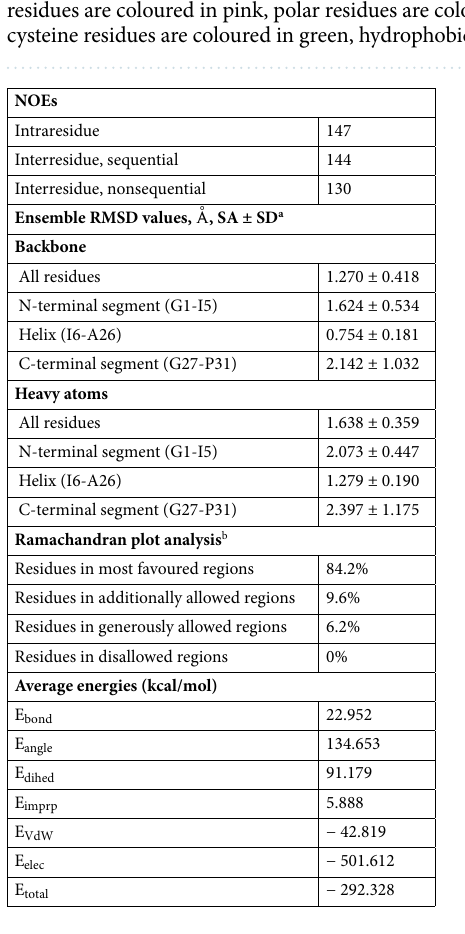
Table 2. Mean structural statistics of the twenty structural models comprising the palustrin-Ca ensemble. The peptide structure has been deposited in the PDB with deposition code 7P4X. Model 10 is the representative medoid structure. a RMSD values from VMD. b Based on